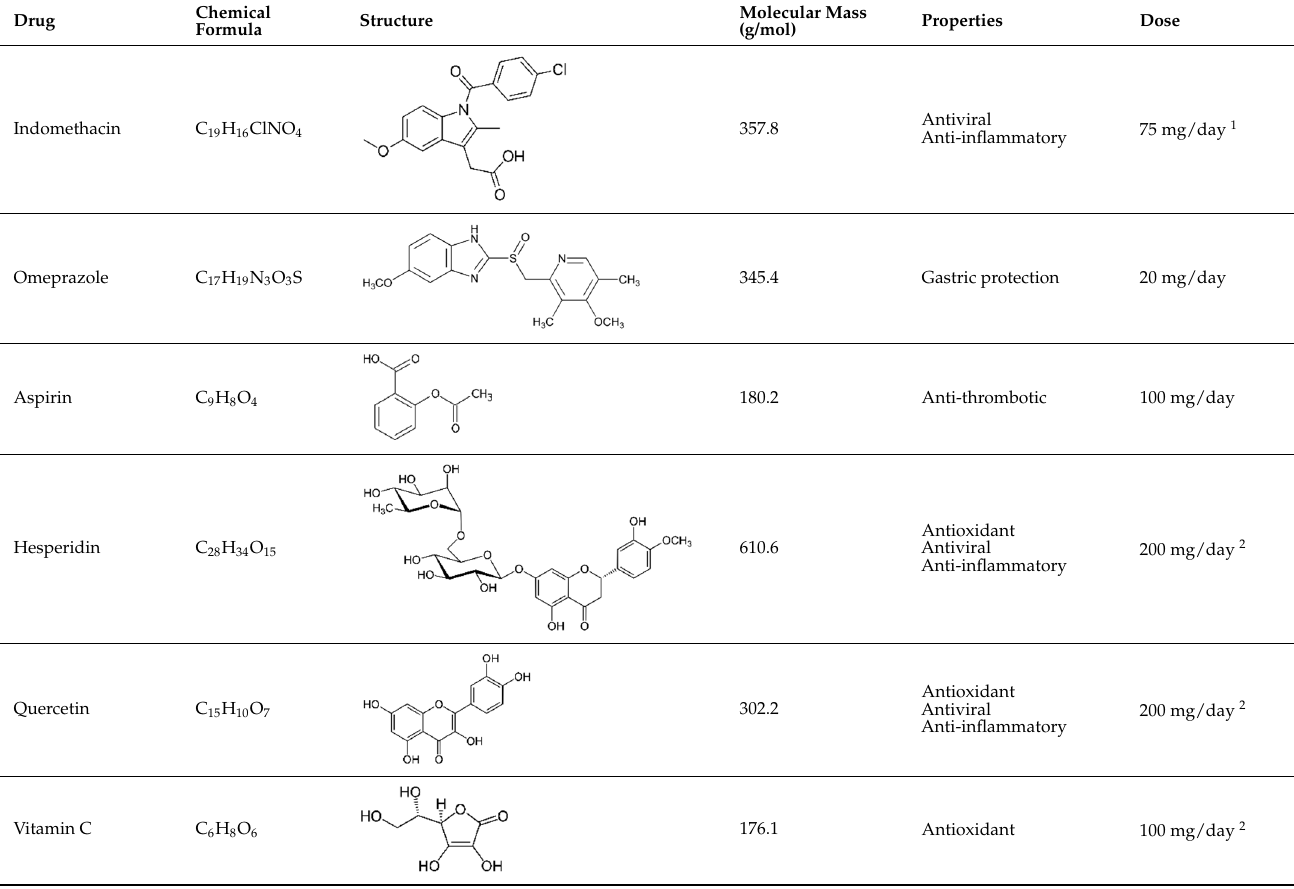
Table 1. Basic components of the synergistic multi-therapy used by Fazio et al. [12] and described in this review.